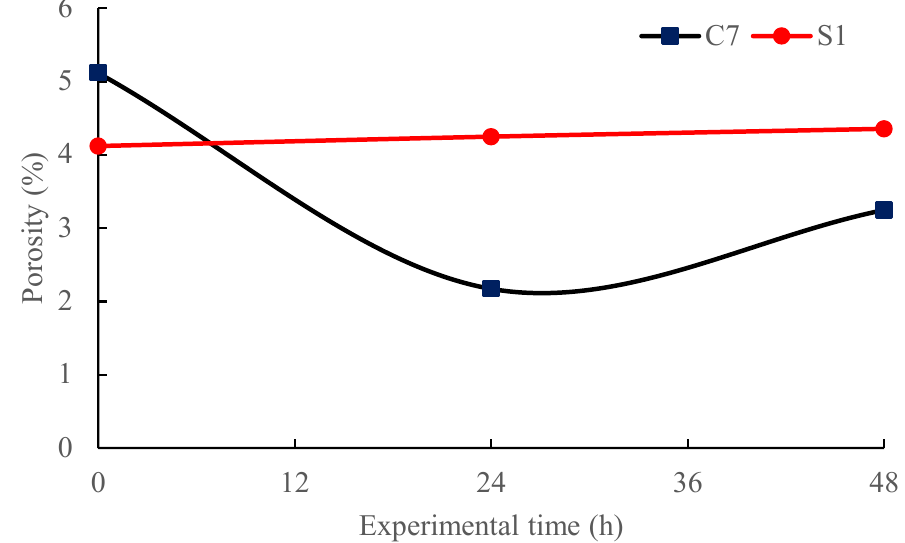
Figure 11. Porosity changes of long-interval (24 h) experiment.